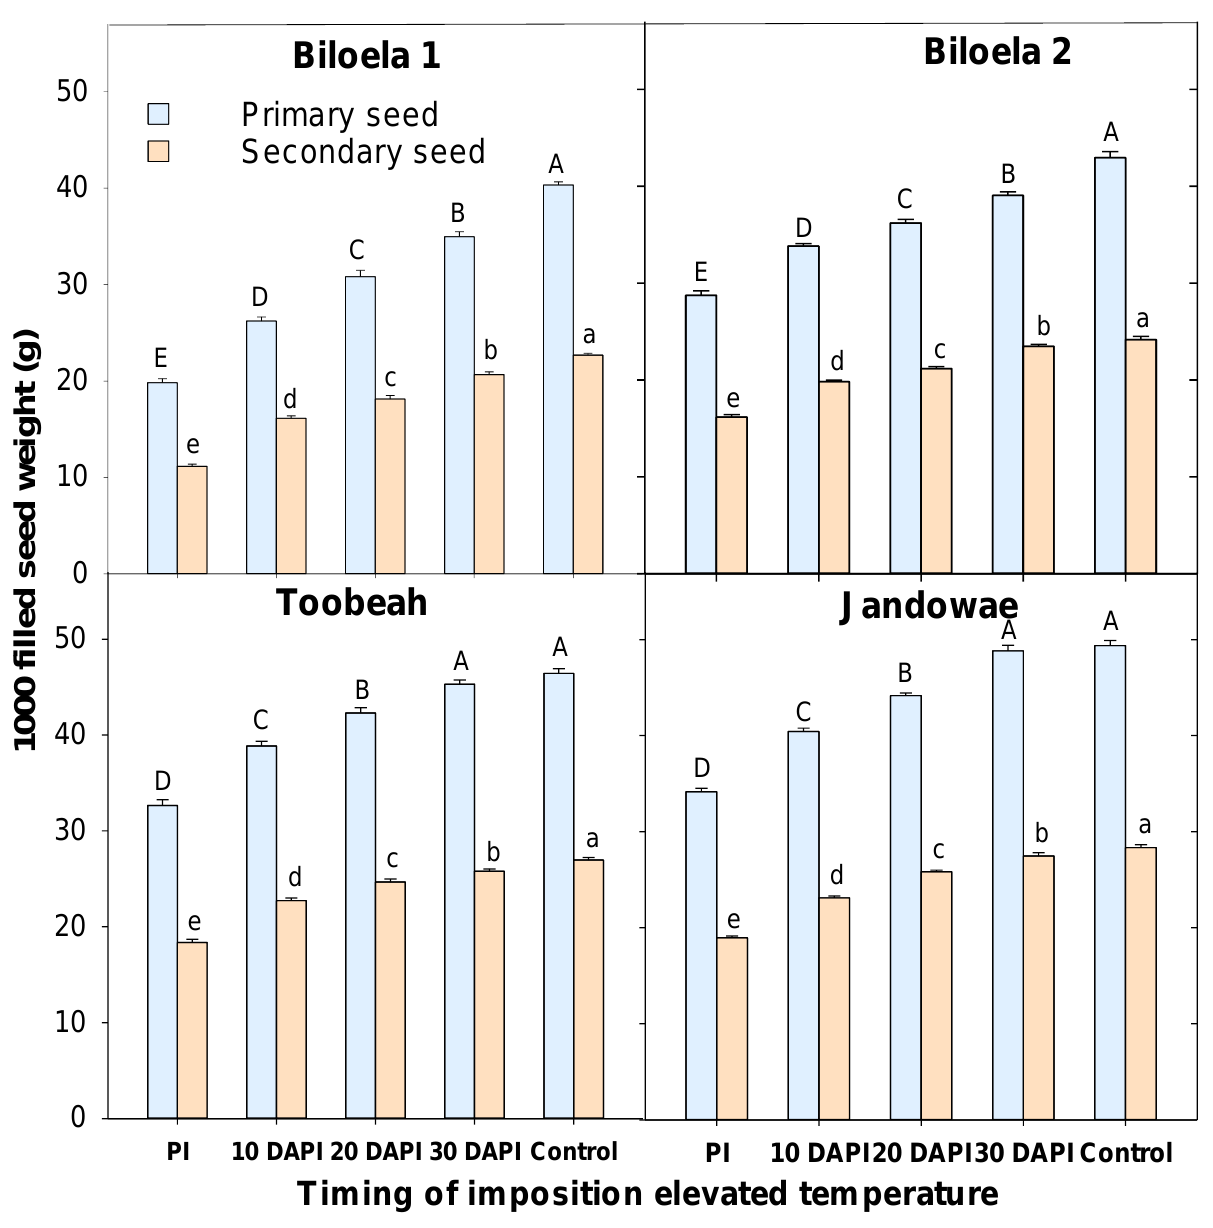
Figure 4. Effect of elevated temperature applied at panicle initiation (PI), 10 days after panicle initiation 10 DAPI, 20 DAPI or 30 DAPI, on the 1000 filled seed weight of both primary and secondary seeds from four Avena sterilis ssp. ludoviciana biotypes. Error bars represent standard errors of the mean of 12 replicates and represent pooled data from two experimental runs. Letters within a biotype indicate significant differences among the treatments (Bonferroni test). Upper- and lower-case letters are used for 1000 primary and 1000 secondary filled seed weight, respectively.